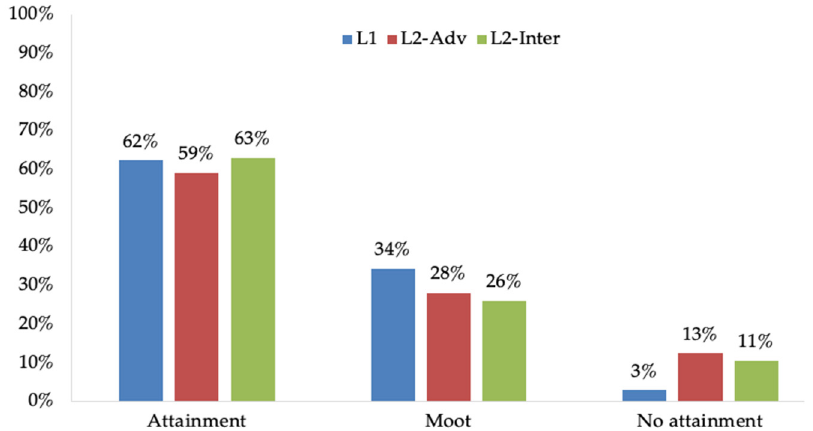
Figure 1. Proportions of choice of state-change attainment by proficiency (L2–Adv: Advanced L2 group; L2–Inter: Intermediate L2 group).